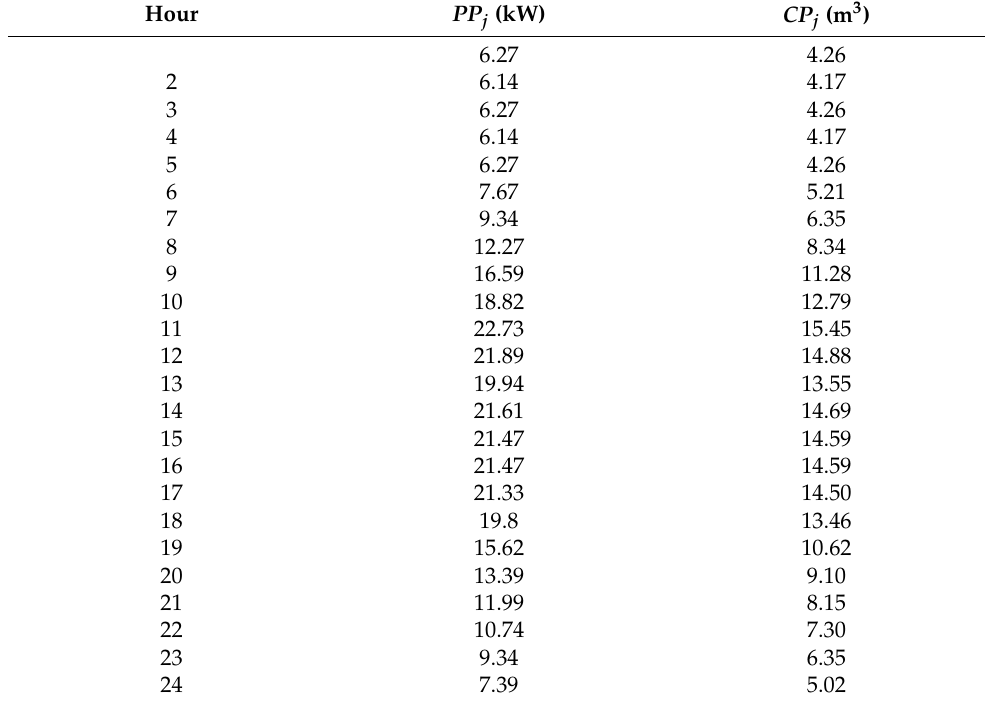
Table 1. Values calculated for CP j to attend the property load